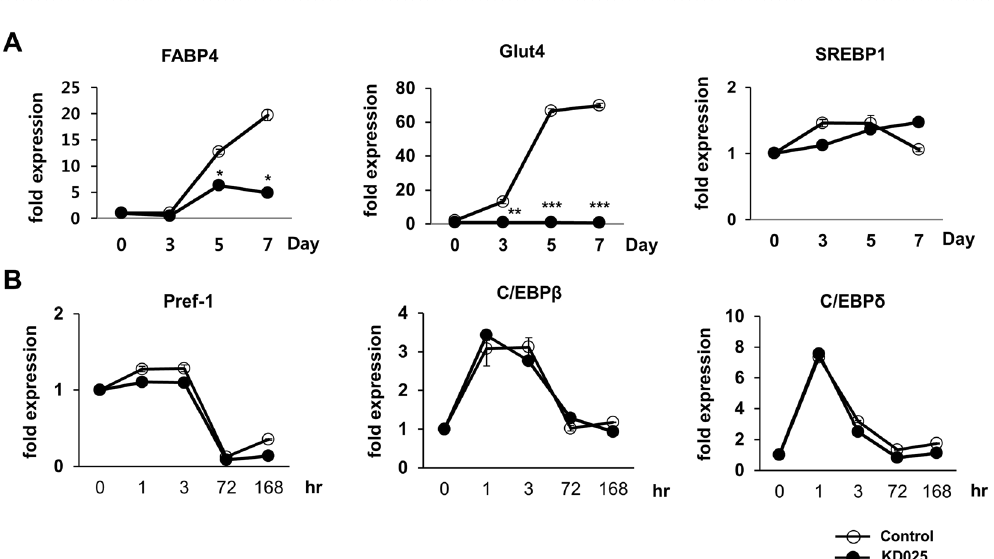
Figure 3. Effects of KD025 on the expression of adipogenic and lipogenic genes. 3T3-L1 cells were differentiated through incubation in DMI with or without KD025 (5 µ M) for the indicated time points and mRNA expression was measured by real time PCR. ( A ) Lipogenic genes: Fabp4, Slc2A4, and Srebp1 . * p < 0.05; ** p < 0.01; *** p < 0.001 vs . the corresponding control condition. ( B ) Pref1 and early activated genes: Cebpb and Cebpd . The data are the representative from more than three independent experiments. Data are expressed as means ± S.E. based on